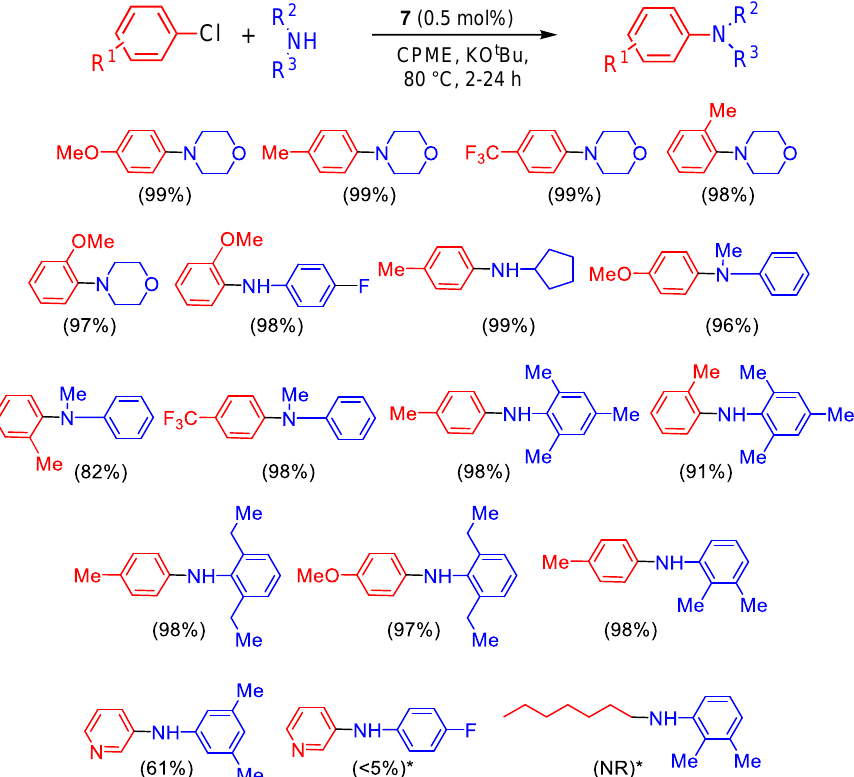
Figure 5. Scope of the Buchwald–Hartwig amination catalyzed by 7 . Reaction conditions: aryl chlorides (1.0 mmol); amine (1.2 mmol); base (1.2 mmol); cat. Pd ( 7 ); solvent (2.0 mL); N 2 ; Isolated yield; * GC yield, 24 h.